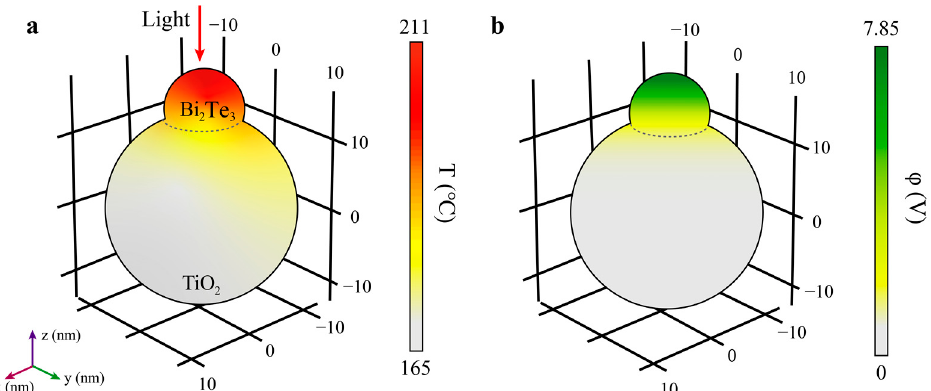
Figure 3. Simulated ( a ) temperature distribution and ( b ) electric potential over pBT(2)/P25 nanocomposite upon a single-wavelength ( λ = 800 nm) light irradiation.